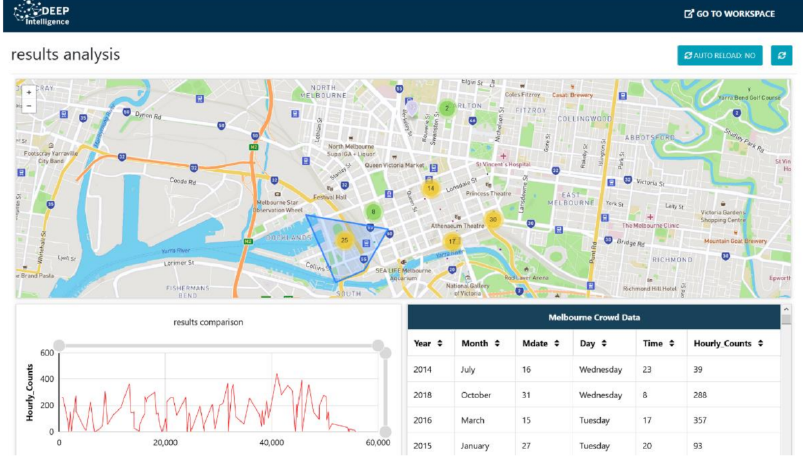
Figure 8. System dashboard for real-time monitoring of crowds, created using